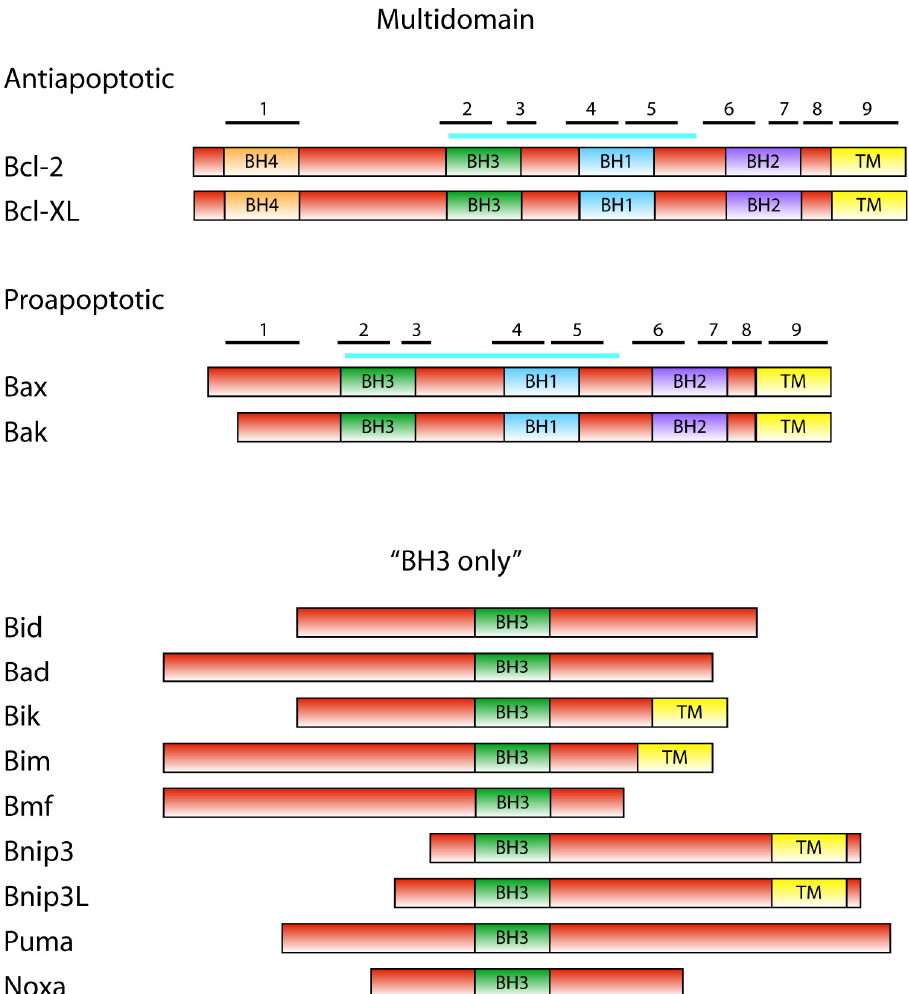
FIGURE 1: The Bcl-2 family. Domain structure of Bcl-2 family proteins is shown schematically with sizes of proteins roughly in scale. Position of BH domains is indicated. In multidomain anti- and proapoptotic proteins, positions of α-helices are indicated with numbered black bars. Blue bar indicates the position of the hydrophobic groove. Members of the Bcl-2 family not studied in yeast and not mentioned in text are